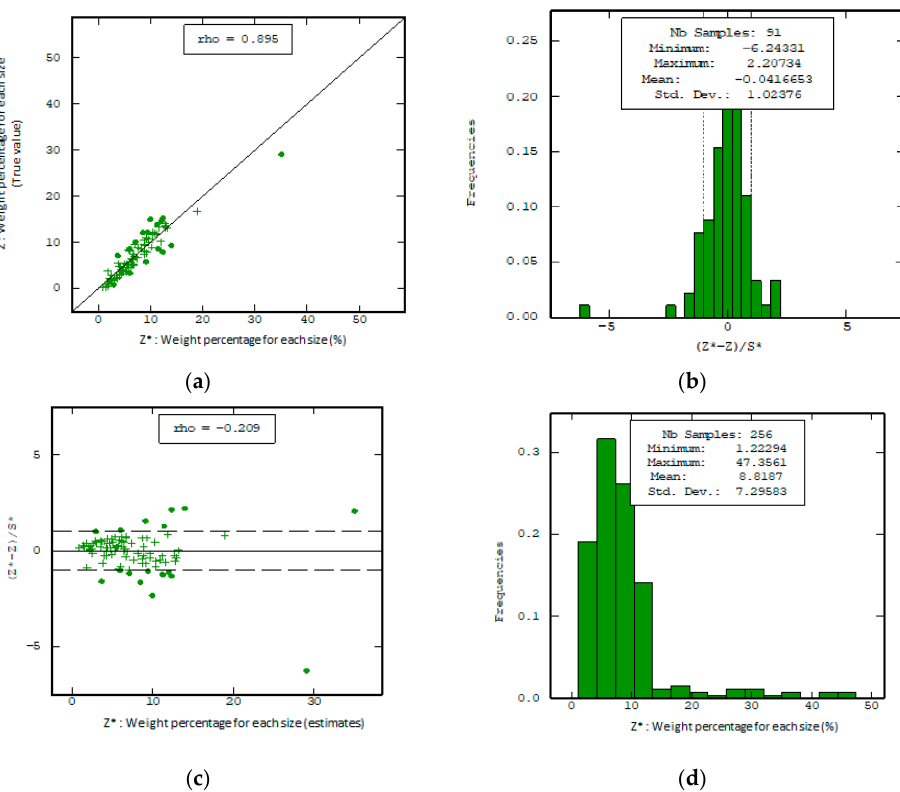
Figure 7. Cross-evaluation of the geostatistical analysis of LGP-1 in ore-A: ( a ) the scatter plot (identity line) on the x-axis is the modeled data, and the y-axis shows the experimental data; ( b ) standardized error histogram; ( c ) standardized error based on the estimated value; and ( d ) histogram and the statistical parameters of the estimated data.